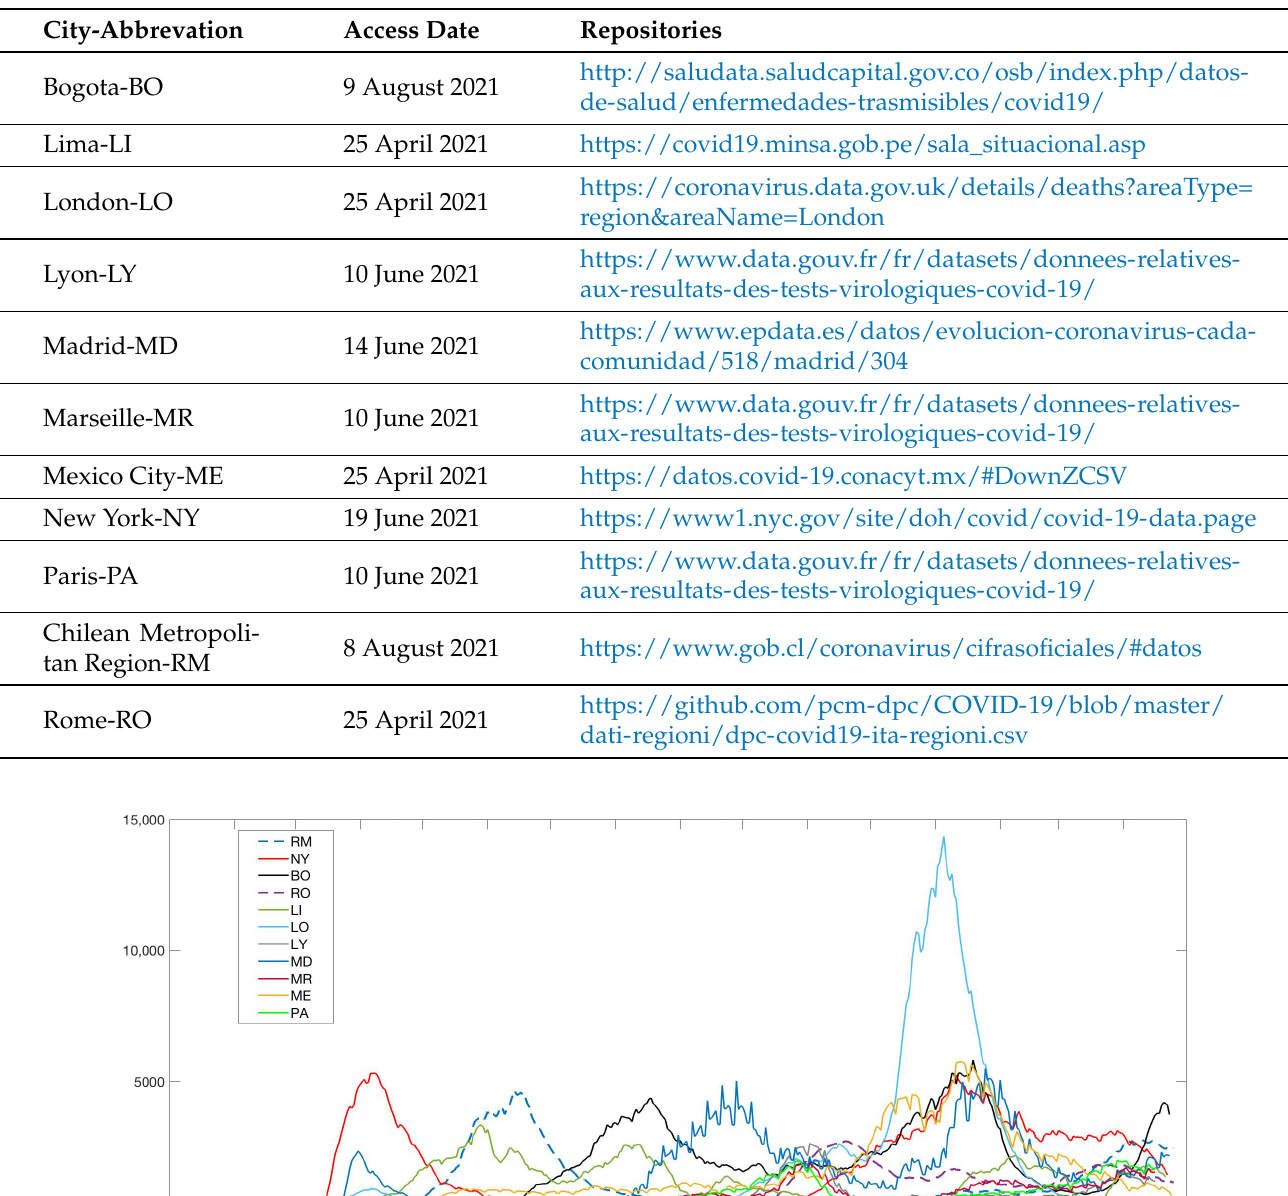
Table 1. List of chosen cities.